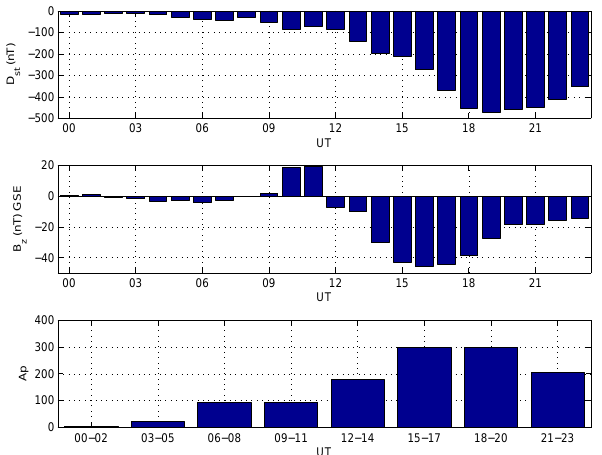
Table 31. Key driver variables for SAMI2 optimised against the ensemble mean from MIDAS, along the latitudinal line segment, for the VTEC feature space, and for different time windows during 20 November 2003. time window optimal parameters